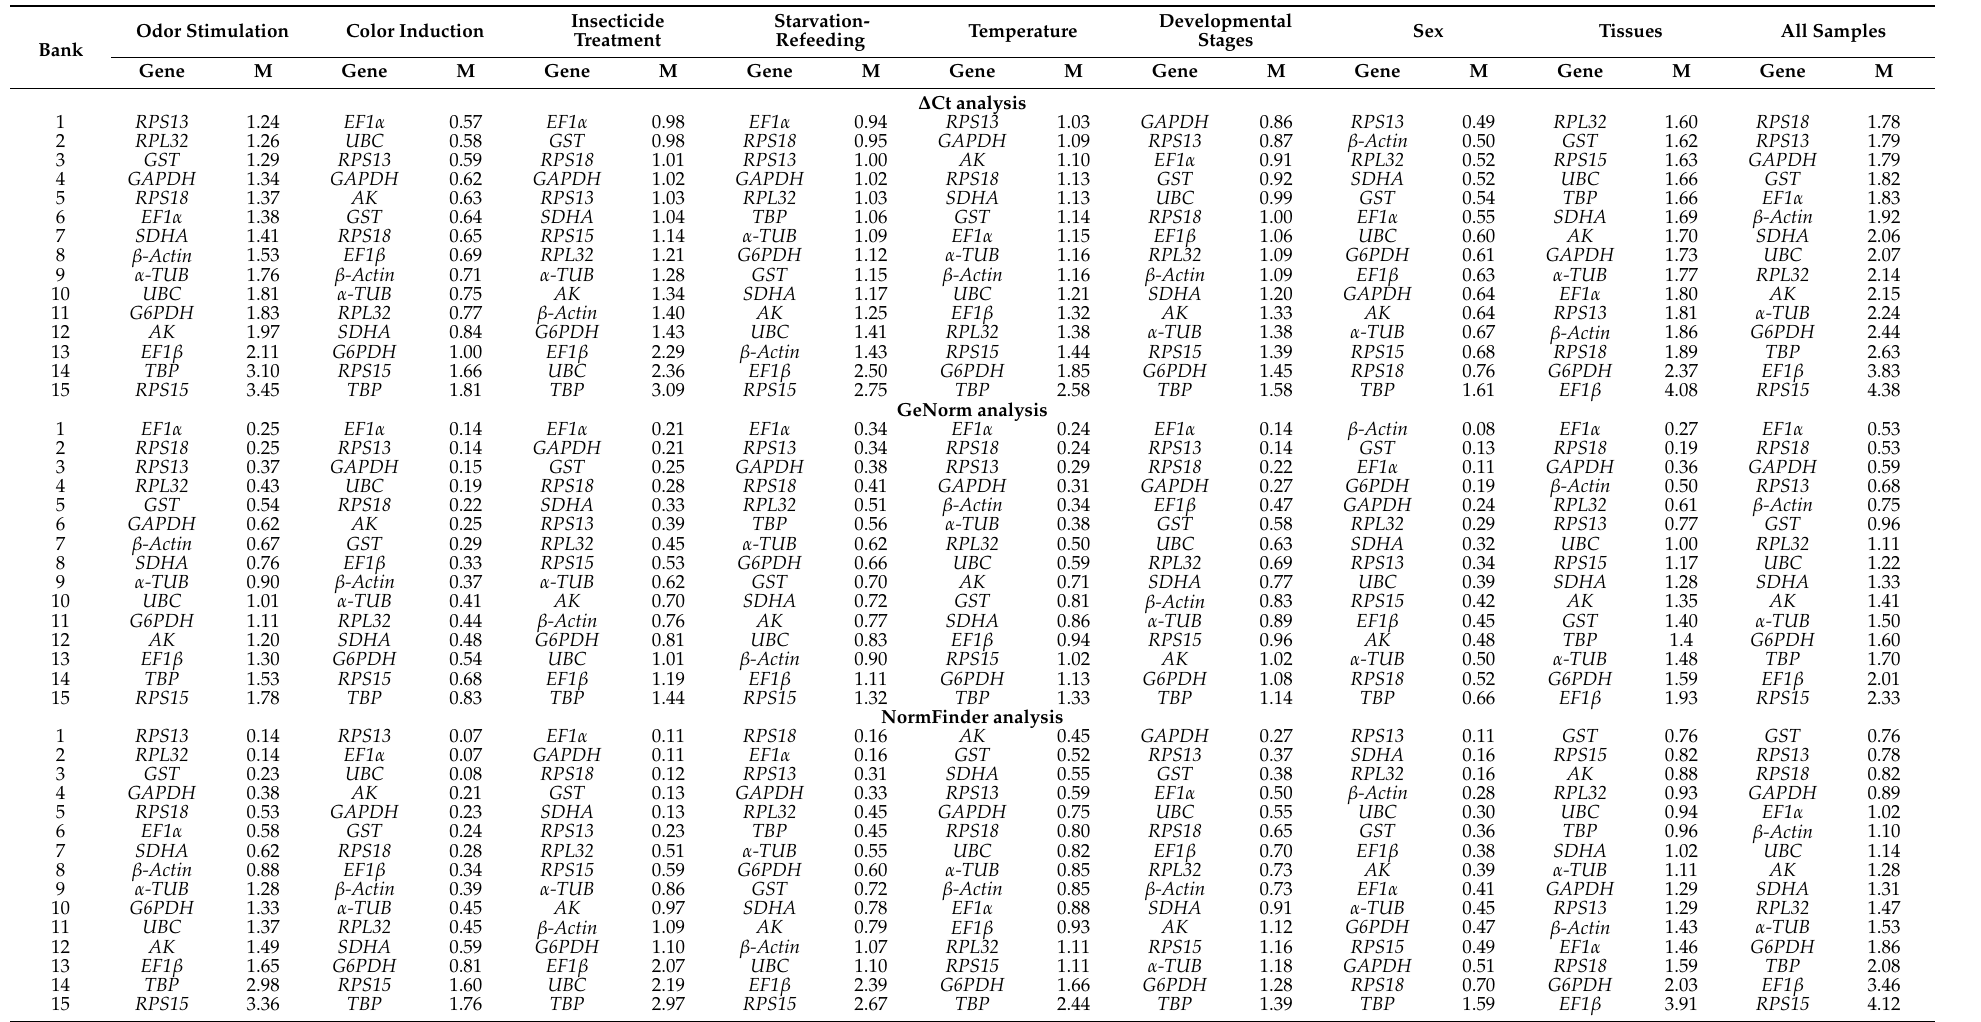
Table 2. Expression stability ranking of 15 candidate reference genes in all samples was calculated using ∆ Ct, GeNorm and NormFinder. The average expression stability (M value) is listed, and the stability decreased from top to